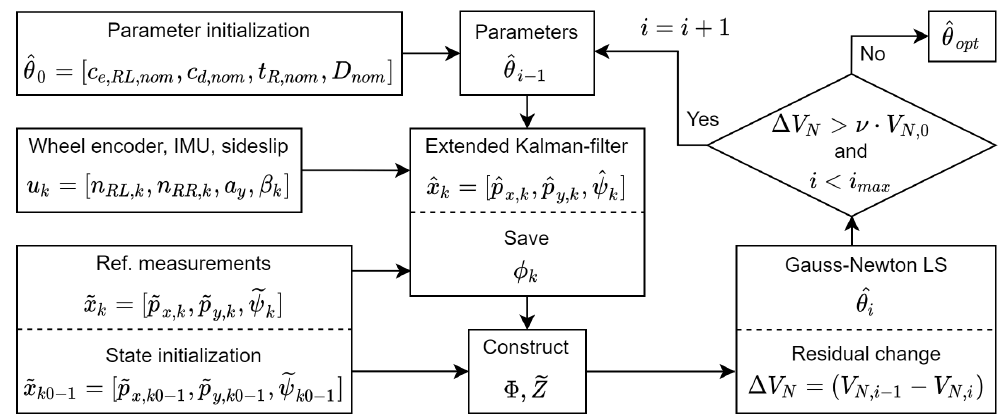
Figure 12. Process of the Gauss–Newton (GN)-Kalman-filter (KF) iterative parameter estimation